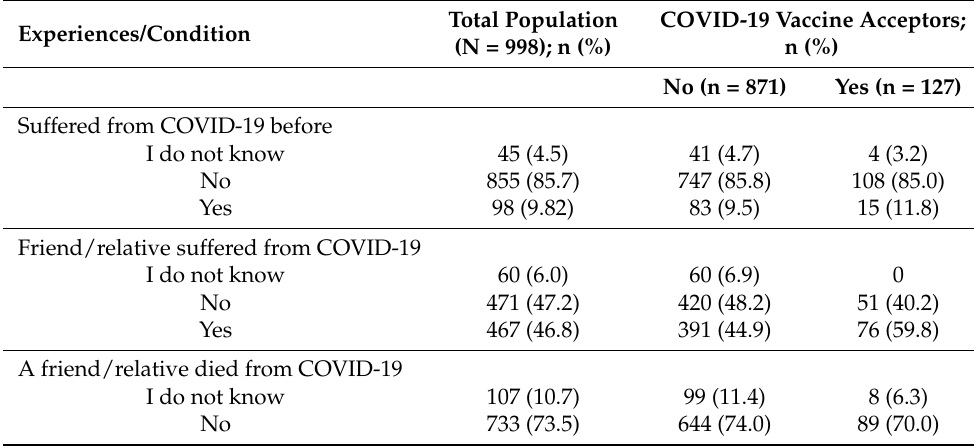
Table 2. COVID-19 experiences of respondents according to vaccine